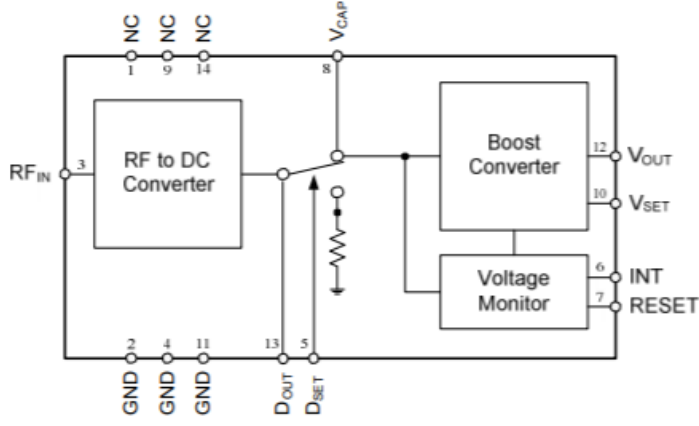
Figure 3. P2110 harvestor circuit block diagram [35].